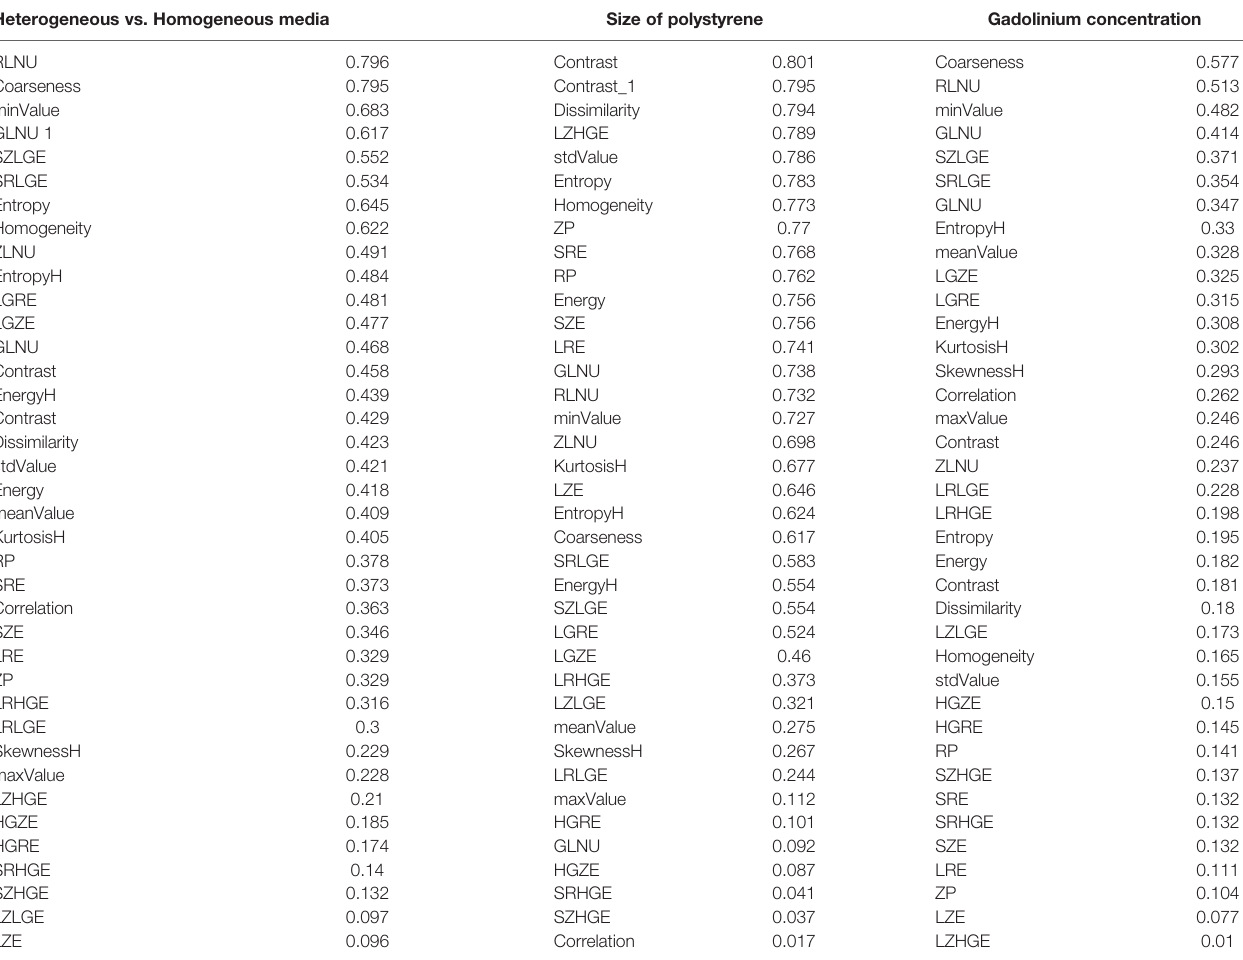
TABLE 3 | Tabulation of textures features and their ability to dissociate the different phantom ’ s tubes at both fi eld strengths separately, regardless to pixel size. Heterogeneous vs. Homogeneous media Size of polystyrene Gadolinium concentration